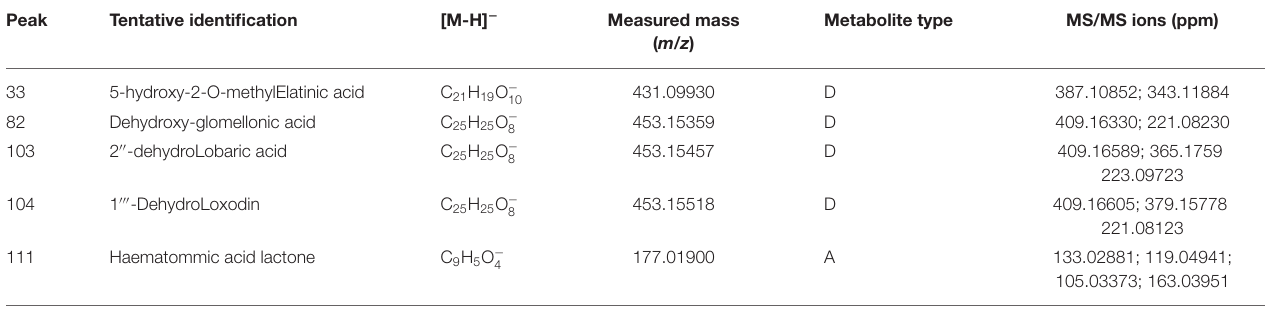
TABLE 1 | Identification of five new compounds in methanolic extract from S. glareosum by UHPLC-ESI-MS/MS.